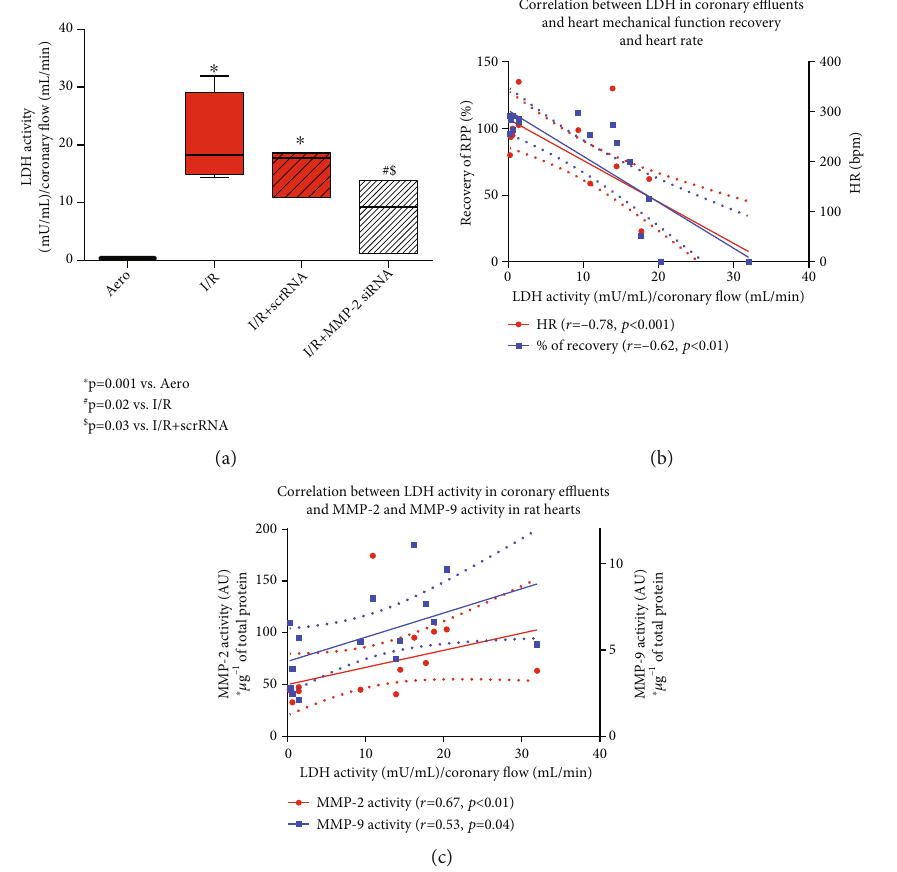
Figure 4: LDH activity in coronary e ffl uents (a). Correlation between LDH activity in coronary e ffl uents and recovery of heart mechanical function and heart rate (b) and correlation between LDH activity in coronary e ffl uents and MMP-2 and MMP-9 activity in heart homogenates (c). Straight line: standard curve; dotted line: 95% con fi dence band. Aero: aerobic control group; I/R: ischemia/reperfusion; HR: heart rate; LDH: lactate dehydrogenase; MMP-2: matrix metalloproteinase 2; MMP-9: matrix metalloproteinase